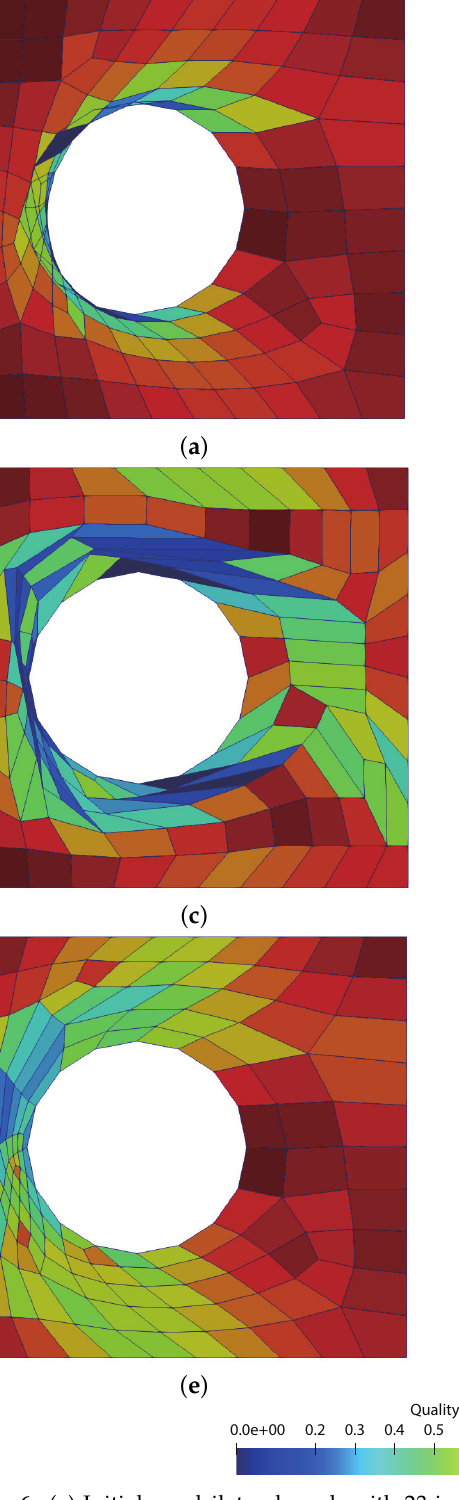
Figure 6. ( a ) Initial quadrilateral mesh with 23 inverted elements. ( b ) Optimized mesh using the Untangle-Beta untangler. ( c ) Optimized mesh using the Size untangler. ( d ) Optimized mesh using the Shape-Size untangler. ( e ) Optimized mesh using the proposed approach. ( f ) Optimized mesh using the Untangle-Beta untangler and the Shape Improve